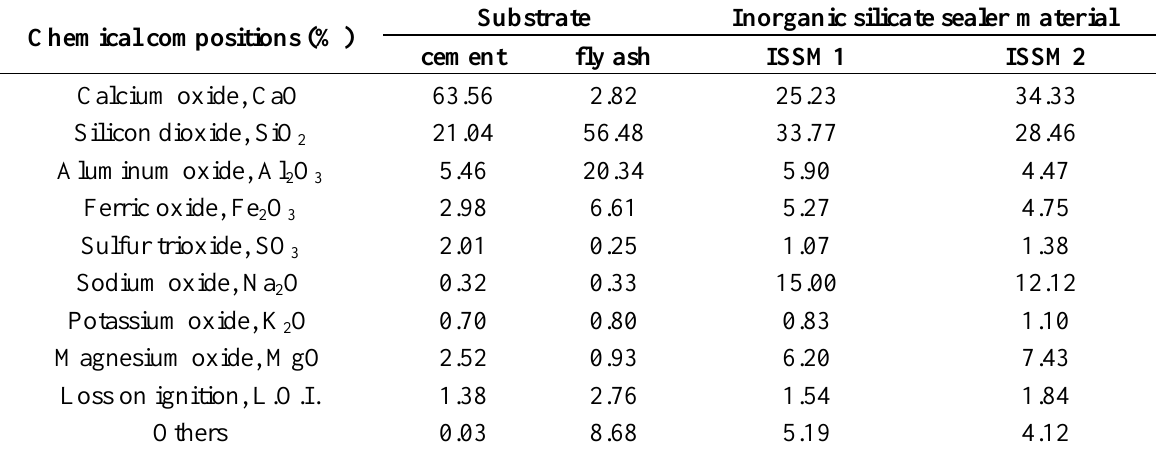
Table 1. Chemical compositions of ISSM, cement, and fly ash.